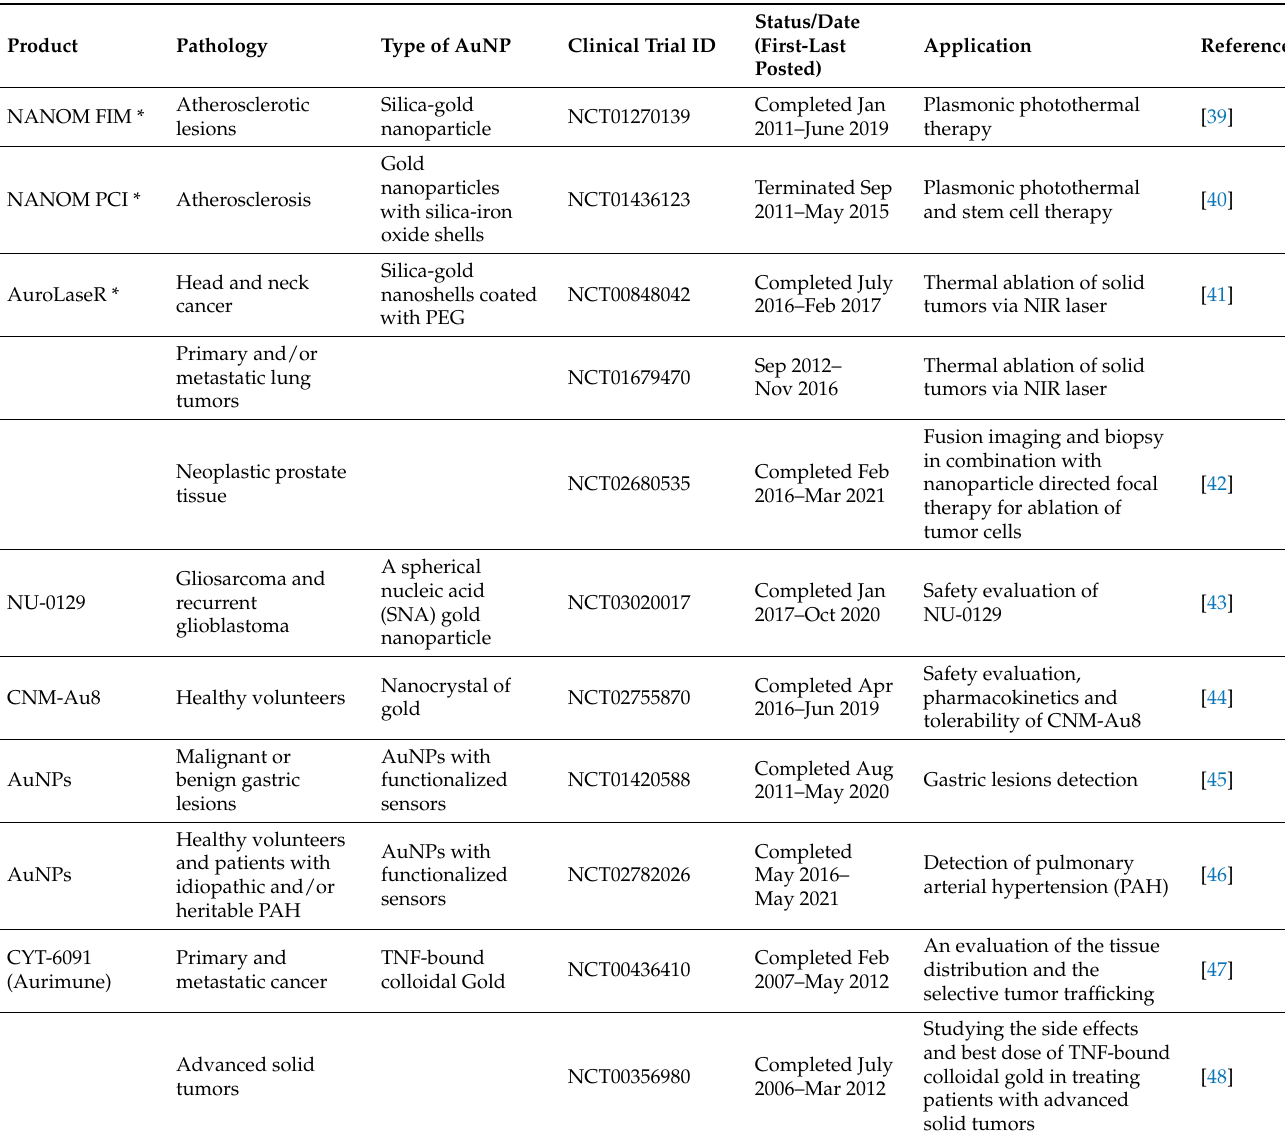
Table 1. Clinical trials on gold